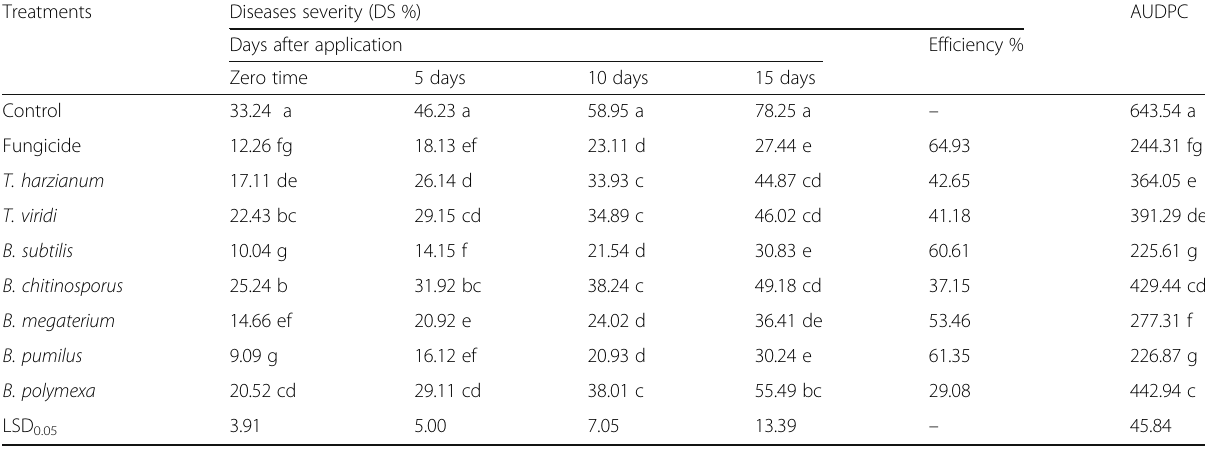
Values are means of three replicates of each treatment Means values for each parameter followed by different letters are significantly different ( P ≤ 0.05), according to Duncan ’ s multiple range